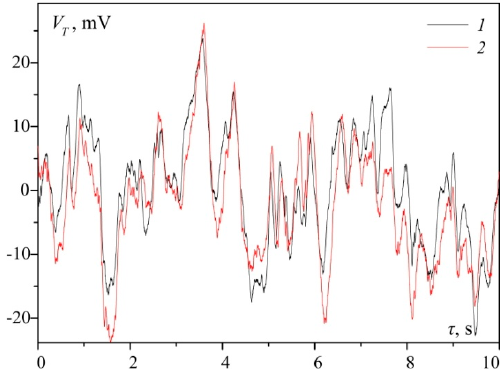
Figure 5. Temperature signal from two thermocouples (after amplification, filtering, and DC trim- ming) at the current 450 A.